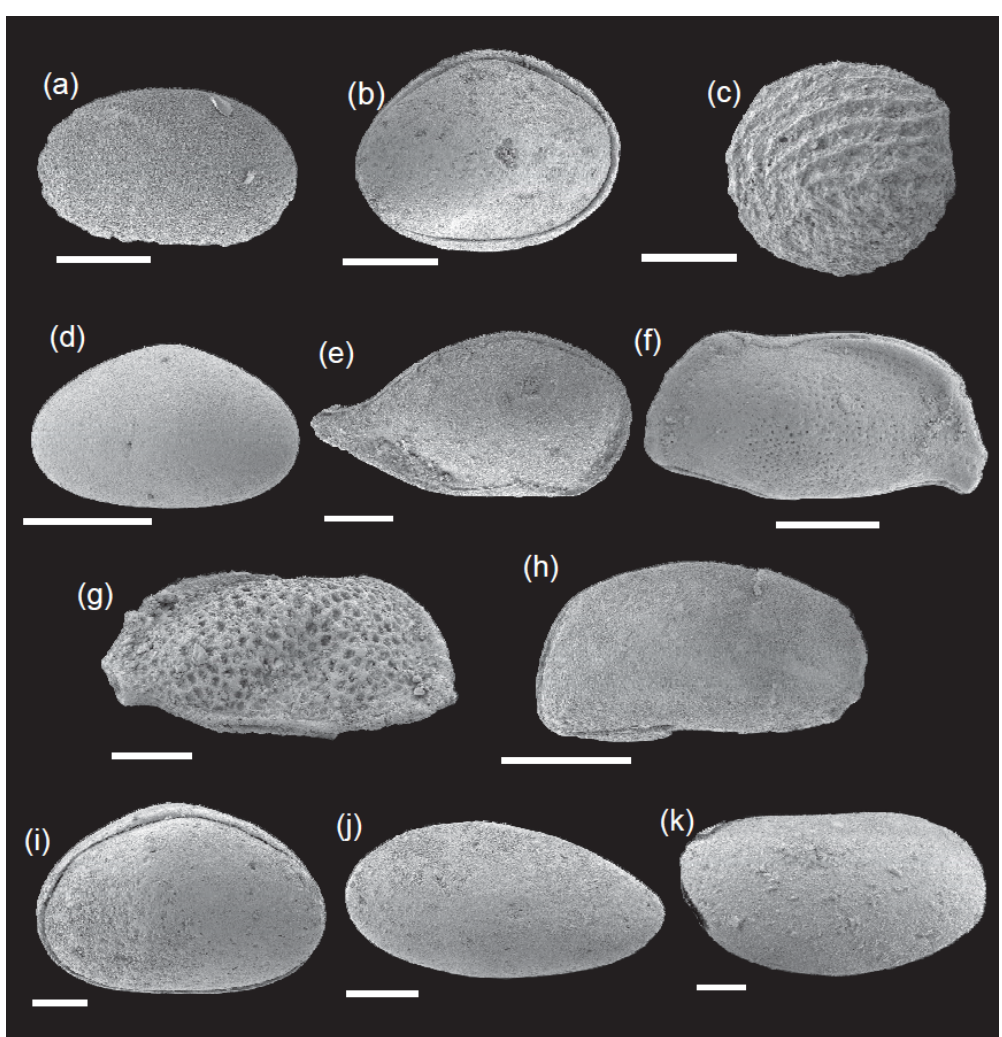
Figure 11. SEM images of ostracods. (a) Ogmoconchella . (b) Ogmoconcha . (c) Polycope . (d) Bairdiacypris . (e) Bairdia . (f, g) Ptychobairdia . (h) Pontocyprella . (i) Cytherella . (j) Liassina . (k) Isobythocypris . Scale bar: